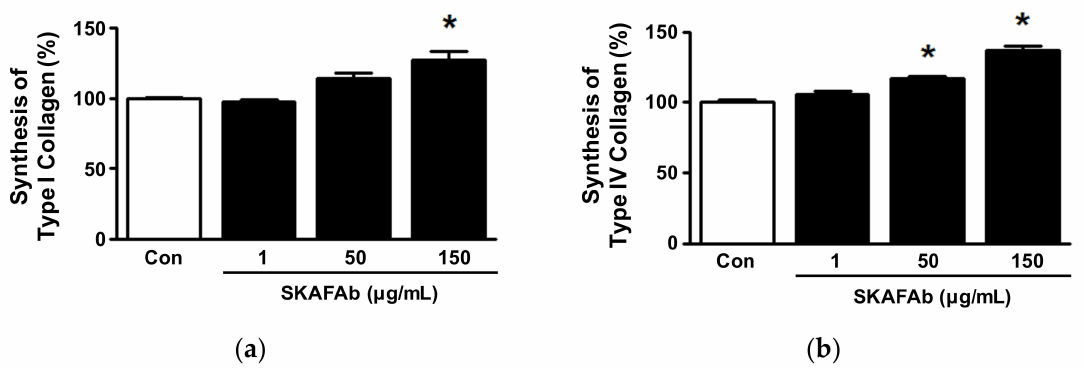
Figure 6. Syntheses of type I and IV collagens by keratinocytes exposed to Salix koreensis Anderss flower absolute. HaCaT cells were treated with or without Salix koreensis Anderss flower absolute (SKAFAb; 1–150 µ g/mL) for 48 h. Conditioned media were subjected to sandwich ELISA using anti-type I ( n = 3; ( a )) or anti-type IV collagen antibody ( n = 3; ( b )). Collagen levels are expressed as percentages of levels in the conditioned media of untreated cells (Con). Values are presented as means ± SEMs. p -values by one-way ANOVA are 0.0126 ( a ) and 0.0015 ( b ), respectively. * p < 0.05 vs. untreated cells (by a Tukey’ post hoc